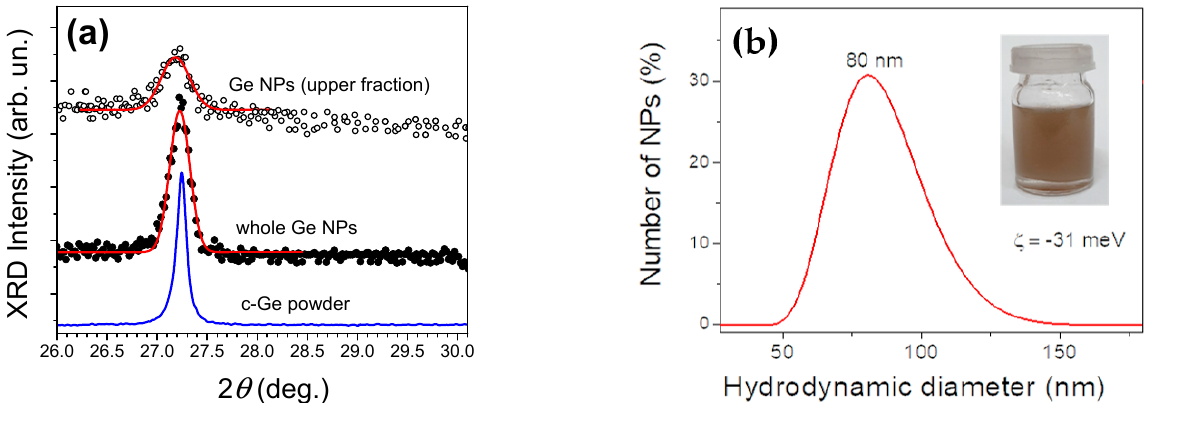
Figure 3. ( a ) XRD spectra in the vicinity of the (111) crystalline lattice of c-Ge from dried suspensions of Ge2.5/2.5 NPs (open and dark circles) after applying Gaussian function fits (red lines) and that of a c-Ge powder (grey line); the middle and upper spectra correspond to Ge NPs from the integral (whole) ensemble and the small size fraction (upper fraction), respectively. ( b ) Size distribution of Ge NPs from the DLS data. Inset shows the photographic image of a vessel with Ge NP suspension in ethanol.